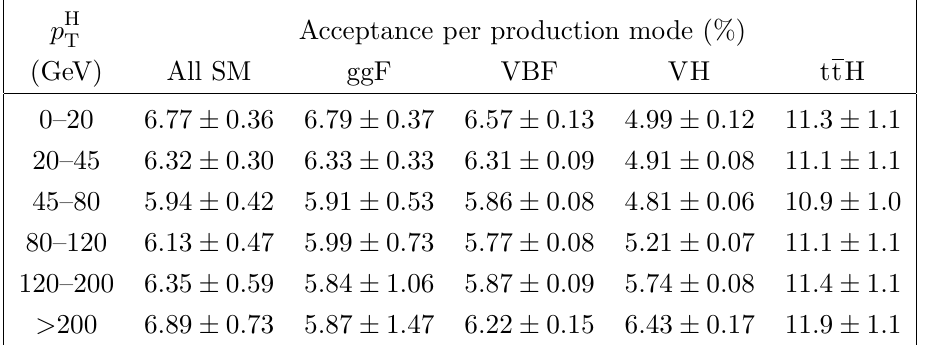
Table 3 . Acceptance of each GL p H